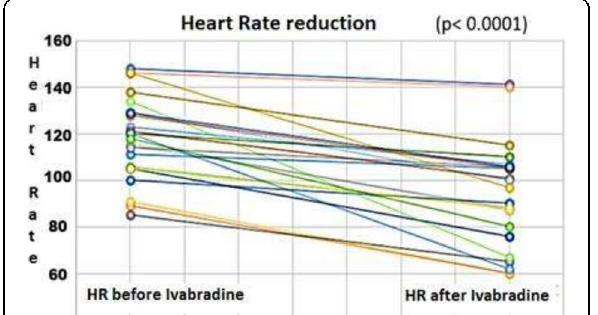
Fig. 1 (abstract 0336). Heart rate before and after Ivabradine administration